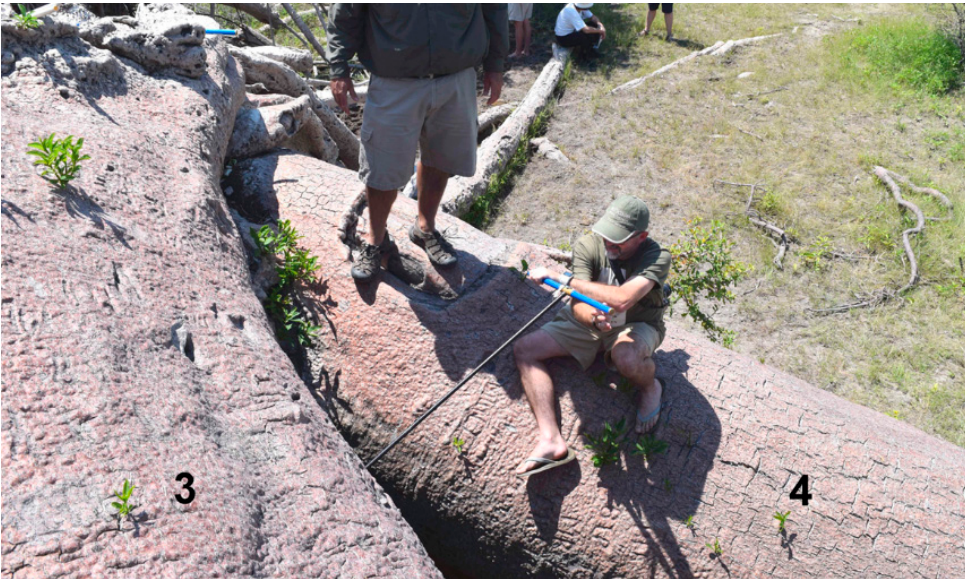
Figure 5. Collecting very long samples from the collapsed stem 3.